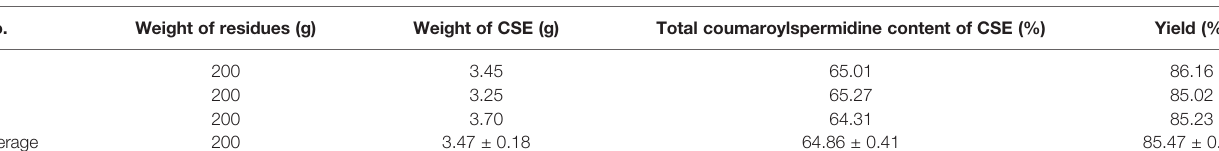
TABLE 1 | Data for the preparation of CSE from Saf fl ower Injection residues.